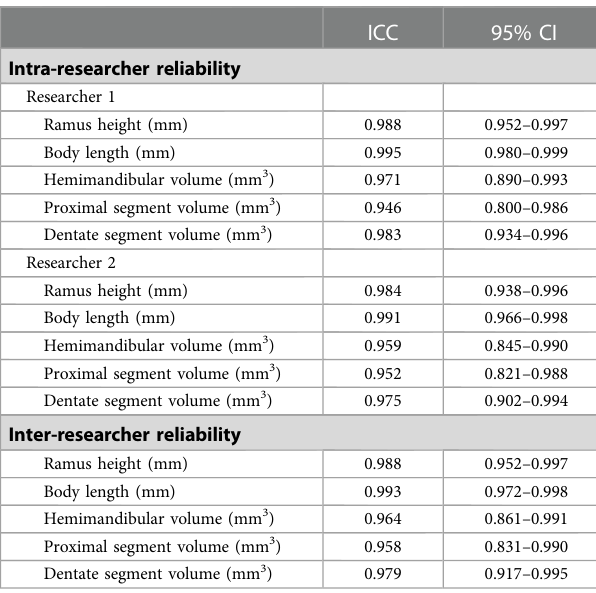
TABLE 2 Inter- and intra-researcher reliability